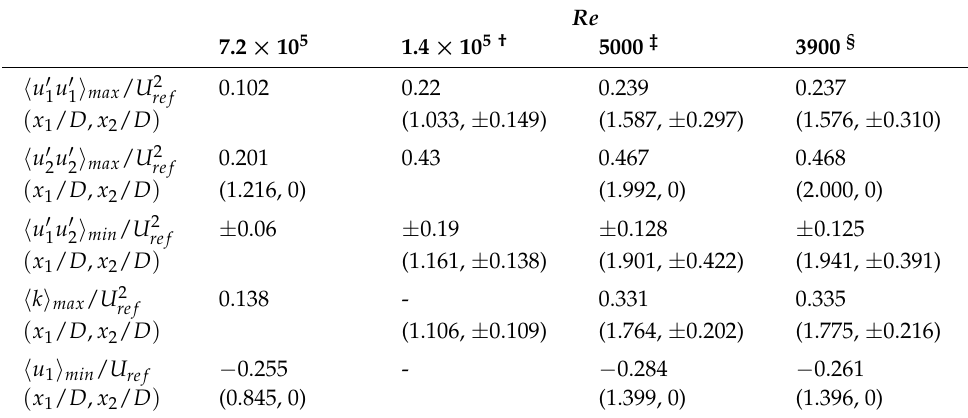
and minimum stream-wise ref Re